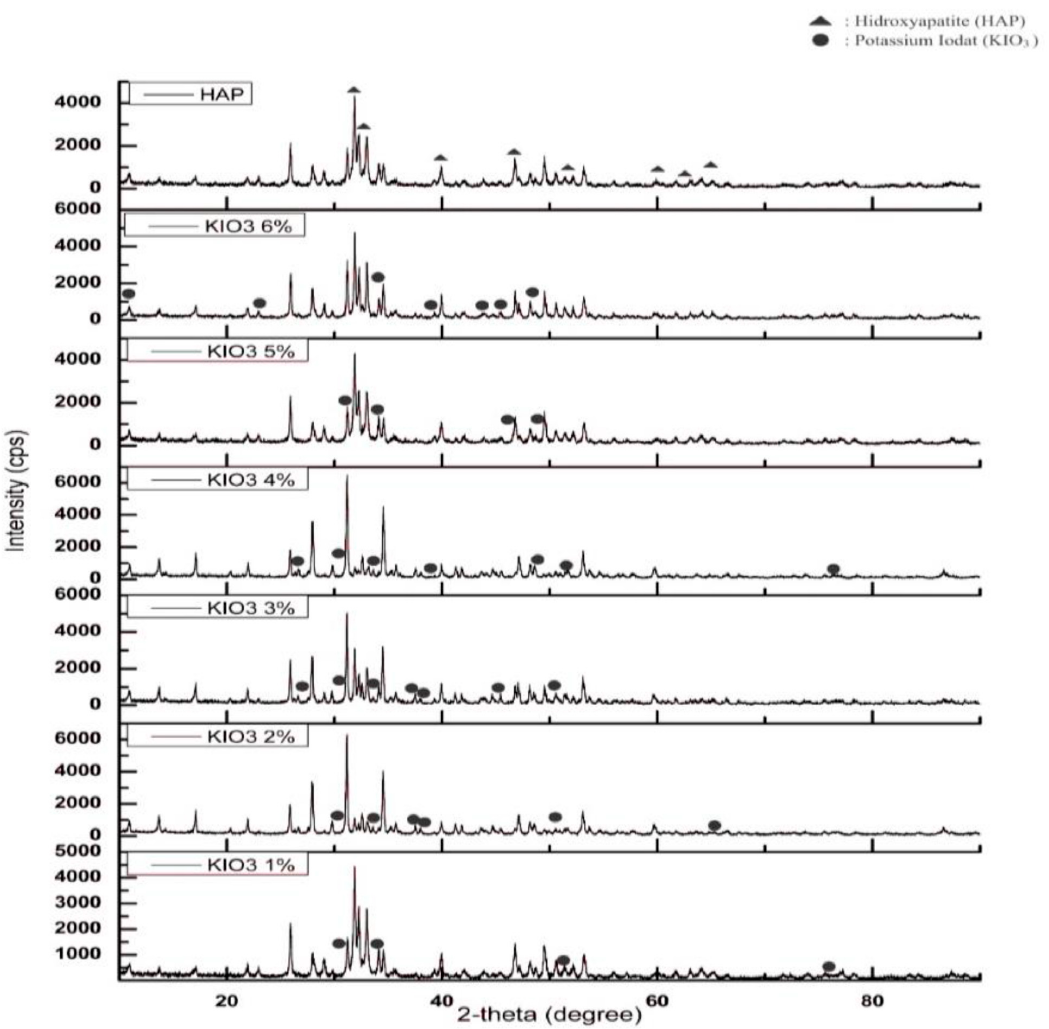
Figure 3. XRD pattern of HAP and KIO 3 / HAP catalyst.